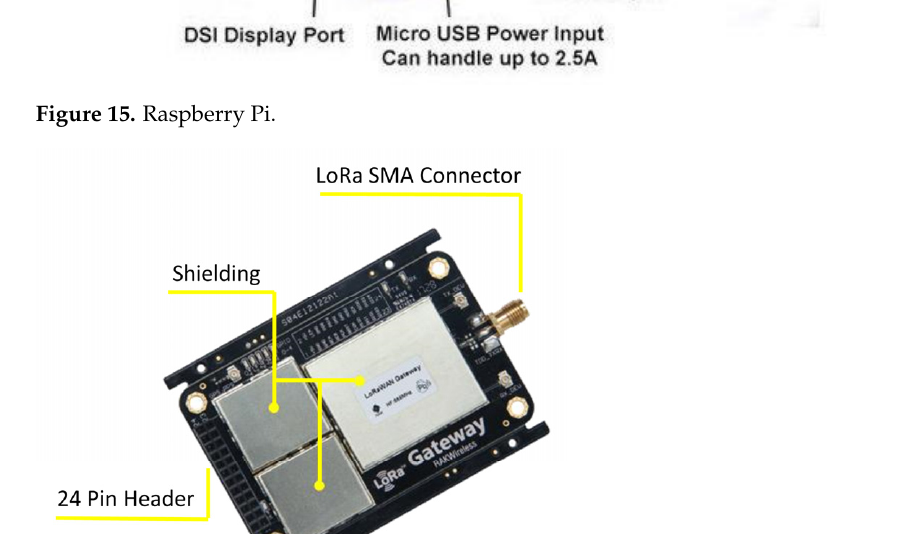
Figure 16. RAK831 Figure 16. RAK831 Module.